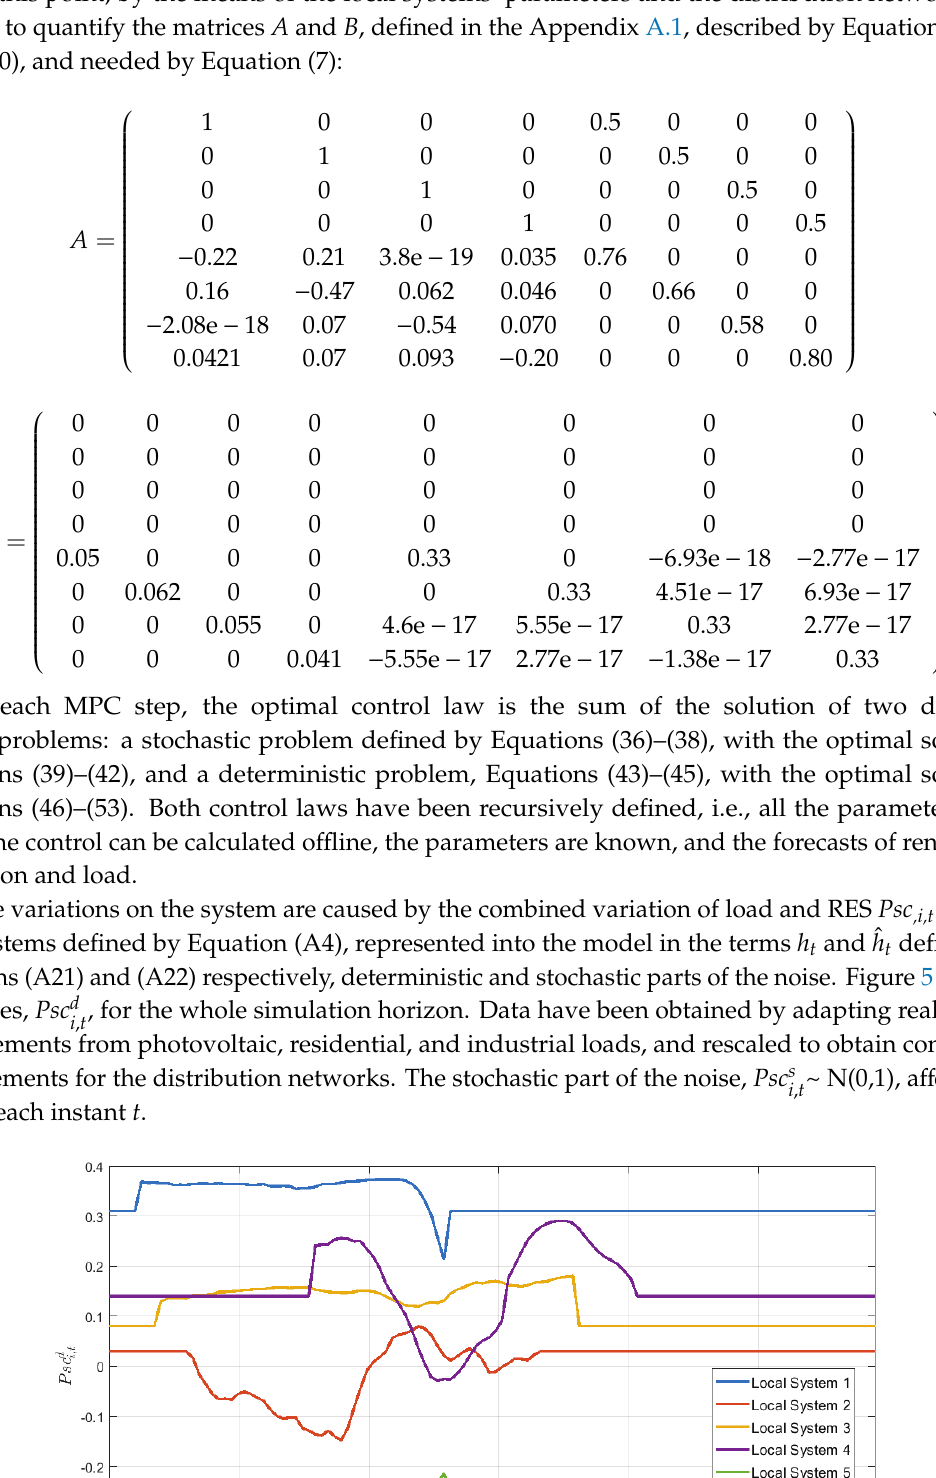
(di ff erence between renewable generation and load), i , t d Psc (difference between renewable generation and (cid:15) i t